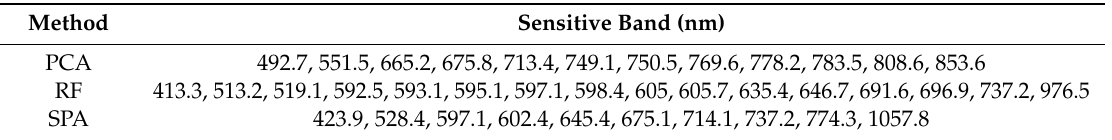
Figure 6. Comparison of characteristic band selection using ( a ) principal component analysis (PCA), ( b ) random forest (RF), and ( c ) the SPA. Table 2. Selected sensitive bands derived from PCA, RF, and the SPA.